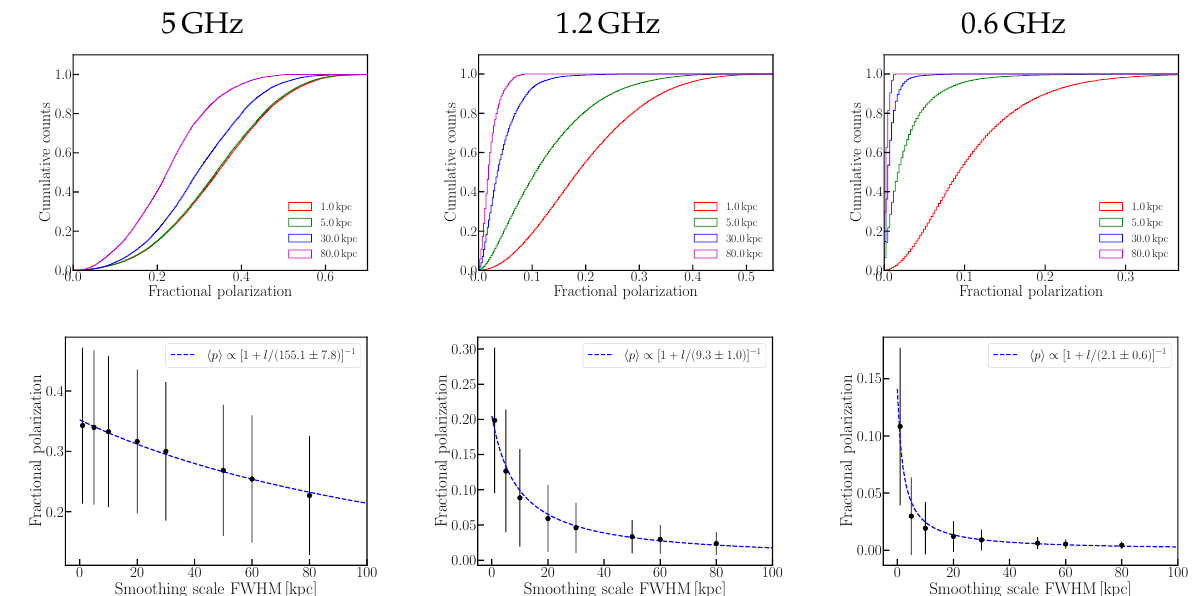
Figure 5. Effect of smoothing by different scales on the fractional polarization ( p ) obtained from l f = 256kpc at t / t ed = 23. ( Top panel ): Cumulative distribution of p for smoothing by different scales. ( Bottom panel ): Variation of the mean p fractional polarization as a function of the smoothing scale ( l ). The dashed blue curve show the best-fit to the points (cid:104) (cid:105) using Equation (2). ( Left, middle and right rows ) are for synthetic observations at 5, 1.2 and 0.6 GHz,